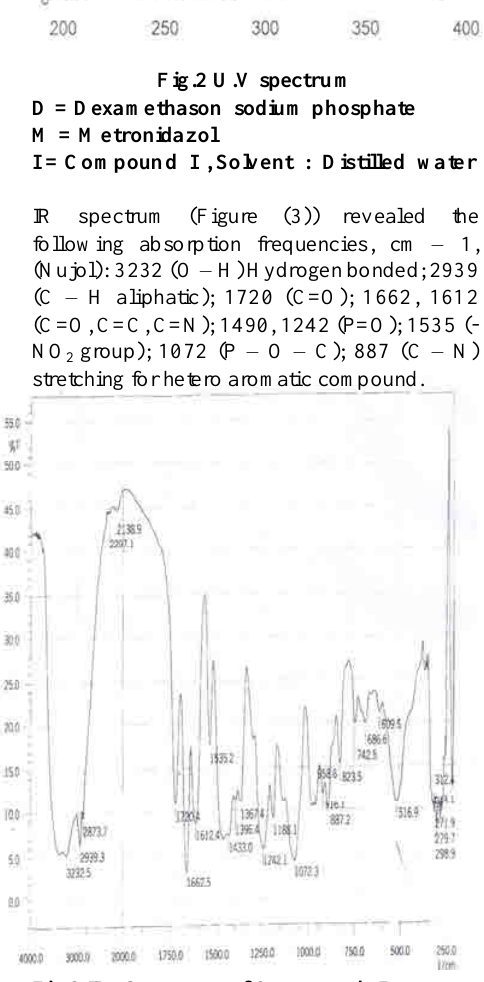
Fig.2 U.V spectrum